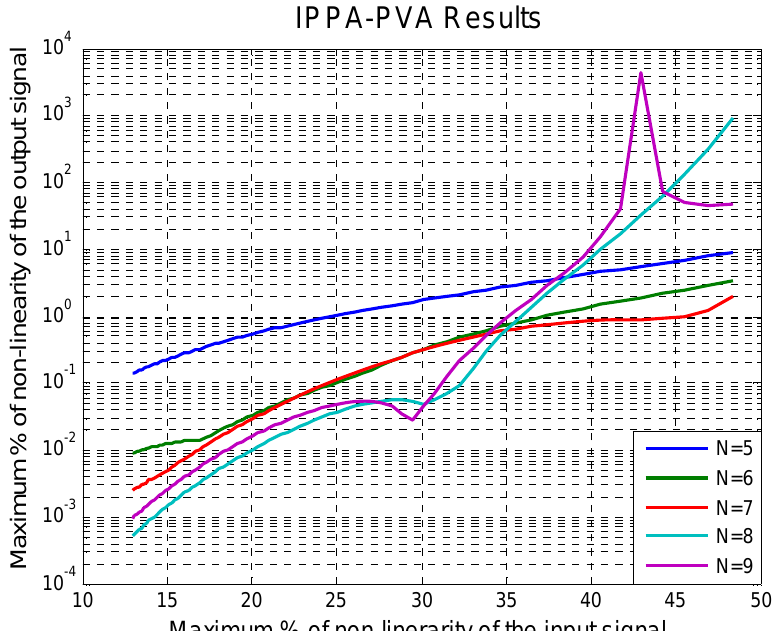
Figure 7. Results of the improved polinomial progressive algorithm for